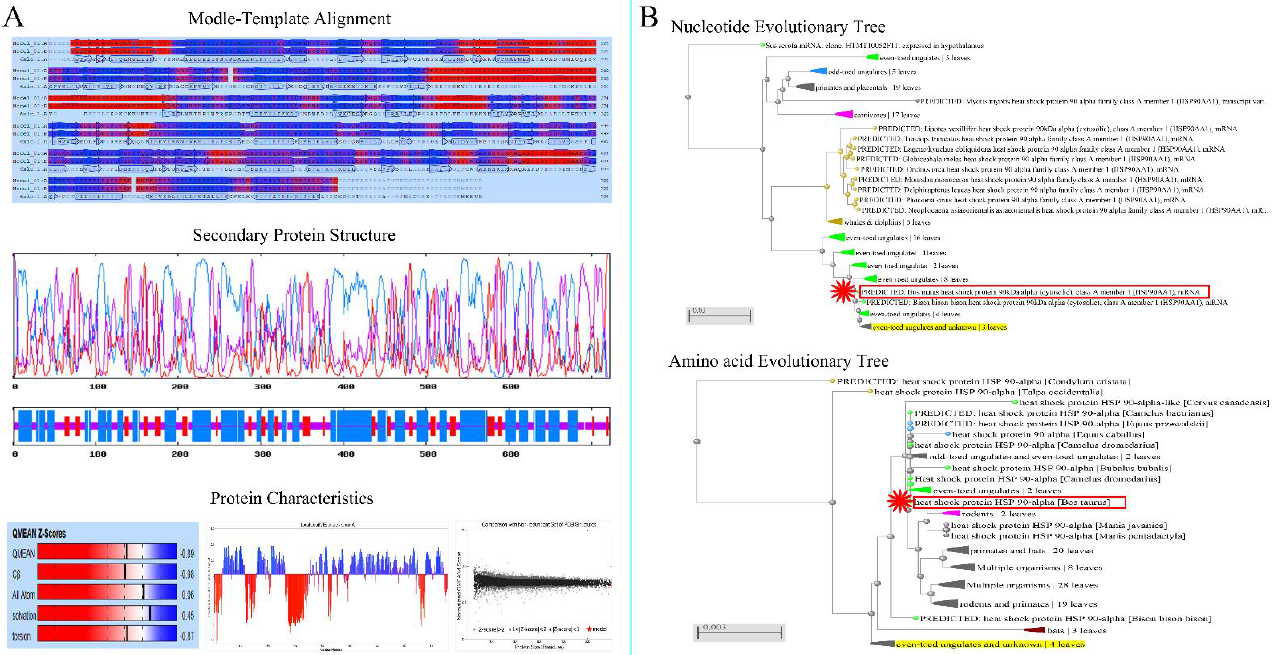
Figure 2. Physicochemical and evolutionary tree analysis of Hsp90 in yak. ( A ) The physical and chemical properties of Hsp90 in yak. Modle-template alignment, secondary protein structure and protein characteristics. ( B ) Homology analysis of amino acids and nucleotides.